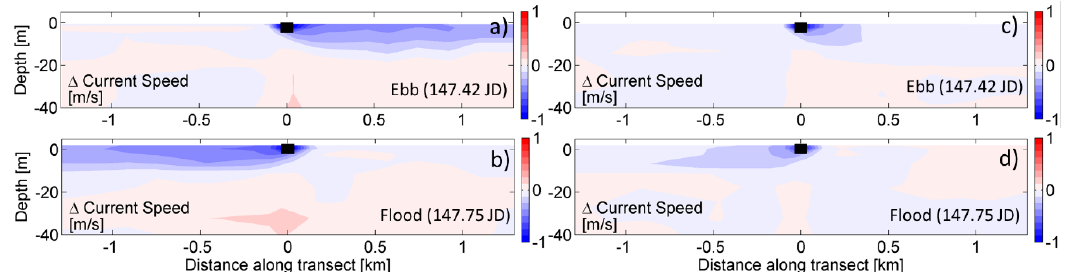
Figure 18. ( a , b ) Velocity difference of baseline scenario with HCB relative to test 1 without HCB during peak ebb and flood; ( c , d ) velocity difference of baseline scenario with HCB relative to test 2 with draw span open during ebb and flood. (Typical spring tide on 27 April 2017).